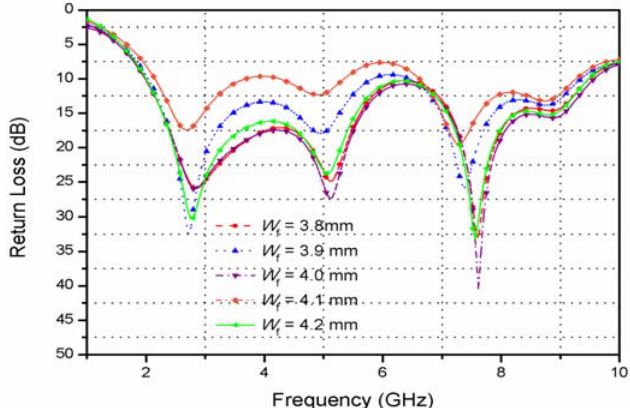
Figure 6: Simulated return loss against frequency for the octagonal ring shape ultra wideband antenna with various : other parameters are the same as listed in Table 1. W f